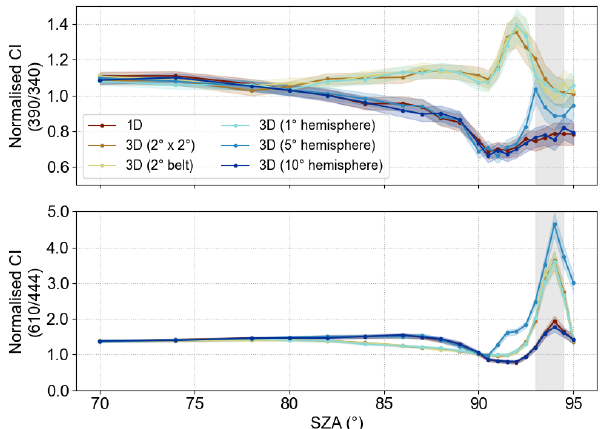
Figure 5. Simulation result (normalised CI) for different 3D ge- ometries (compare to Fig. 1). Details are given in the text. The PSC layer is described by τ PSC = 0 . 05 and h PSC = 20 to